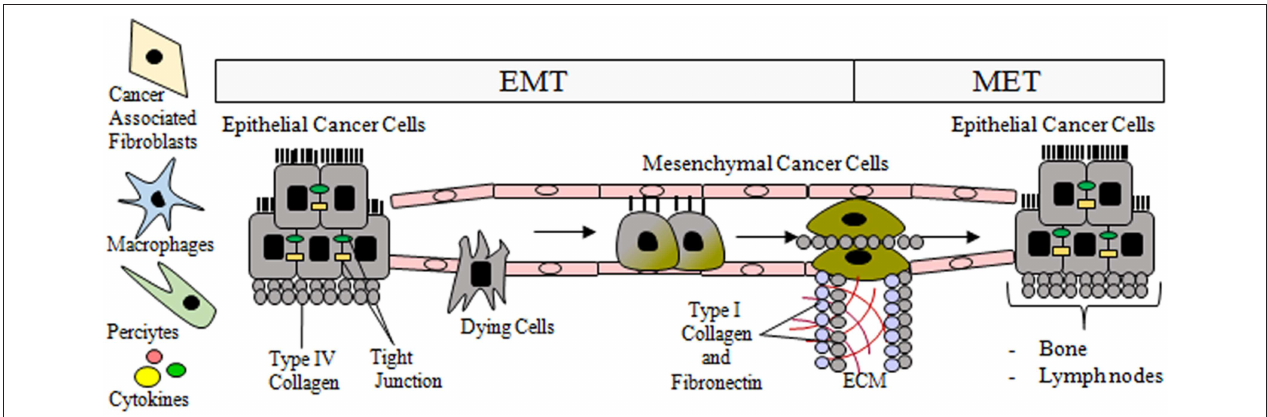
FIGURE 2 | During epithelial mesenchymal-transition (EMT), tubular epithelial cells downregulate the expression of adhesion molecules (E-cadherin, claudins, and cytokeratins), and upregulate mesenchymal markers such as vimentin and fibronectin. Then they undergo a reorganization of the cytoskeleton and morphological alterations. The transition process from epithelial to mesenchymal phenotype is gradual and includes intermediate morphological changes. Post-EMT invasive cells leave the primary tumor and enter the circulatory system via trans-endothelial intravasation where the primary tumor cells can migrate to a capillary or to the lymphatic system, subsequently exiting circulation. As a result of MET, the migrated epithelial cells colonize new tissue (e.g., bones, lymph nodes) and become micrometastases that eventually develop into full